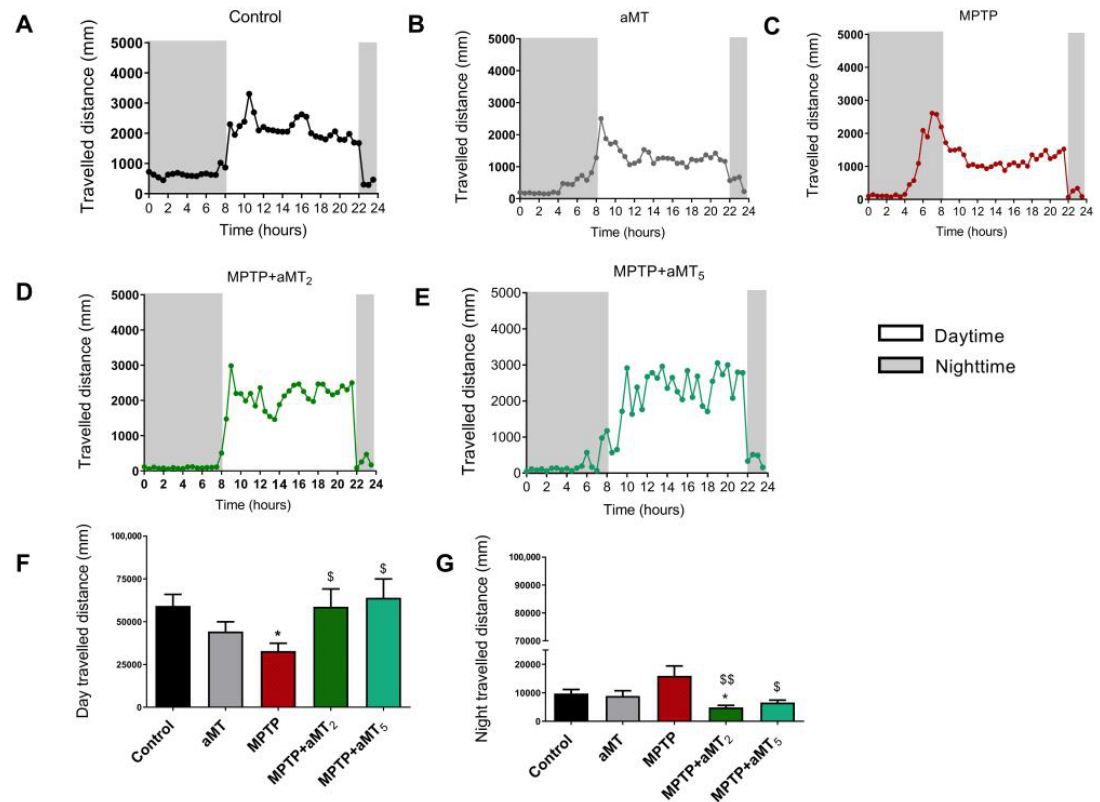
Figure 3. Total distance traveled during 24 h by zebrafish embryos. The light and dark conditions (shaded part) are 14:10 h, respectively. ( A ) control rhythm; ( B ) aMT group; ( C ) MPTP group; ( D ) MPTP+aMT 2 group; ( E ) MPTP+aMT 5 group; ( F ) total day travelled distance; and ( G ) total night trav- elled distance. Data are presented as mean ± SEM. * p < 0.05 vs. control; $ p < 0.05 vs. MPTP; $$ p < 0.01 vs. MPTP. Unpaired t test.